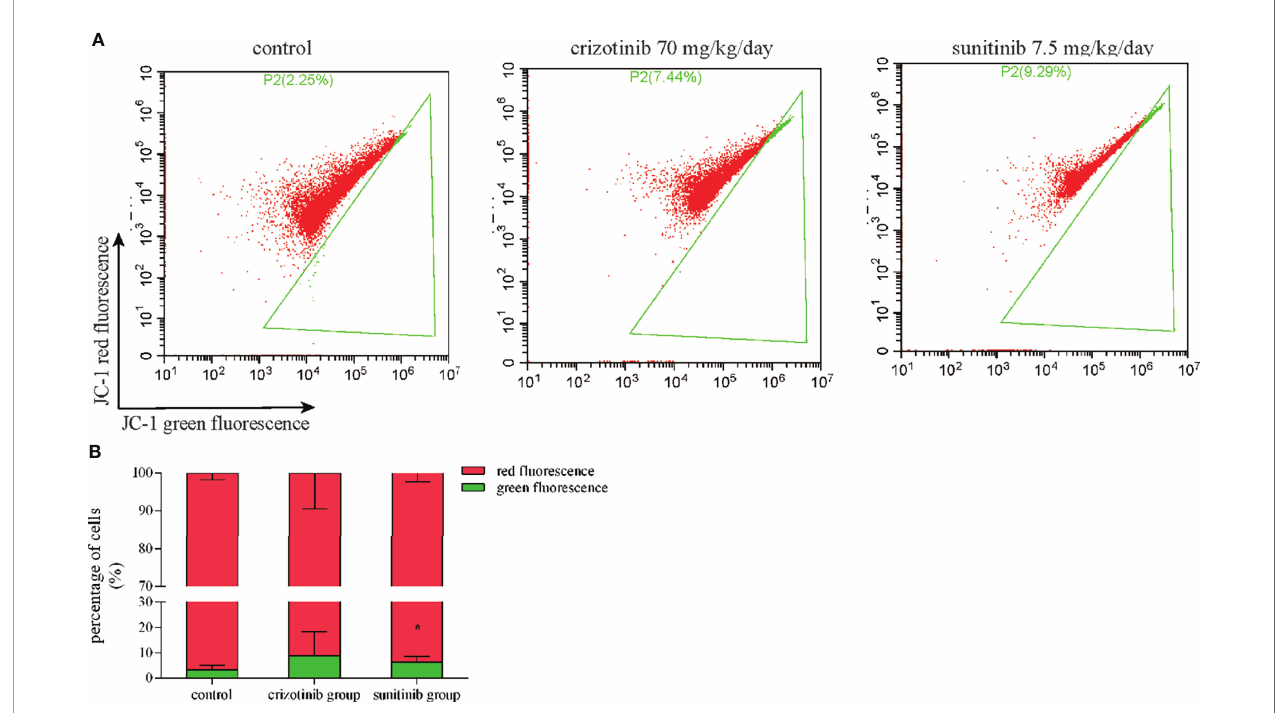
FIGURE 8 | Crizotinib and sunitinib disrupt MMP in liver tissue. (A) Treatment with crizotinib or sunitinib decreased MMP in animals treated for 4 weeks compared to the control group as measured by fl ow cytometry and JC-1 staining. Red fl uorescence represents JC-1 aggregates in the normal mitochondria whereas green fl uorescence represents JC-1 monomer indicating MMP dissipation. (B) Quanti fi cation of high- and low-MMP cells in liver tissue (n = 8). *P < 0.05 (the crizotinib or sunitinib alone vs. control). MMP, mitochondrial membrane